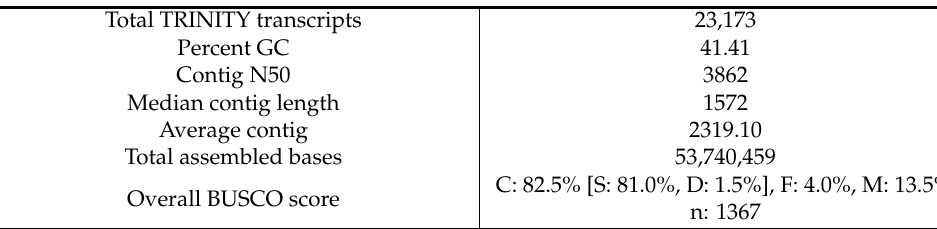
Table 1. Summary statistics of the B. rossius de novo-assembled transcriptome with BUSCO complete- ness and integrity assessment against the Insecta Odb10